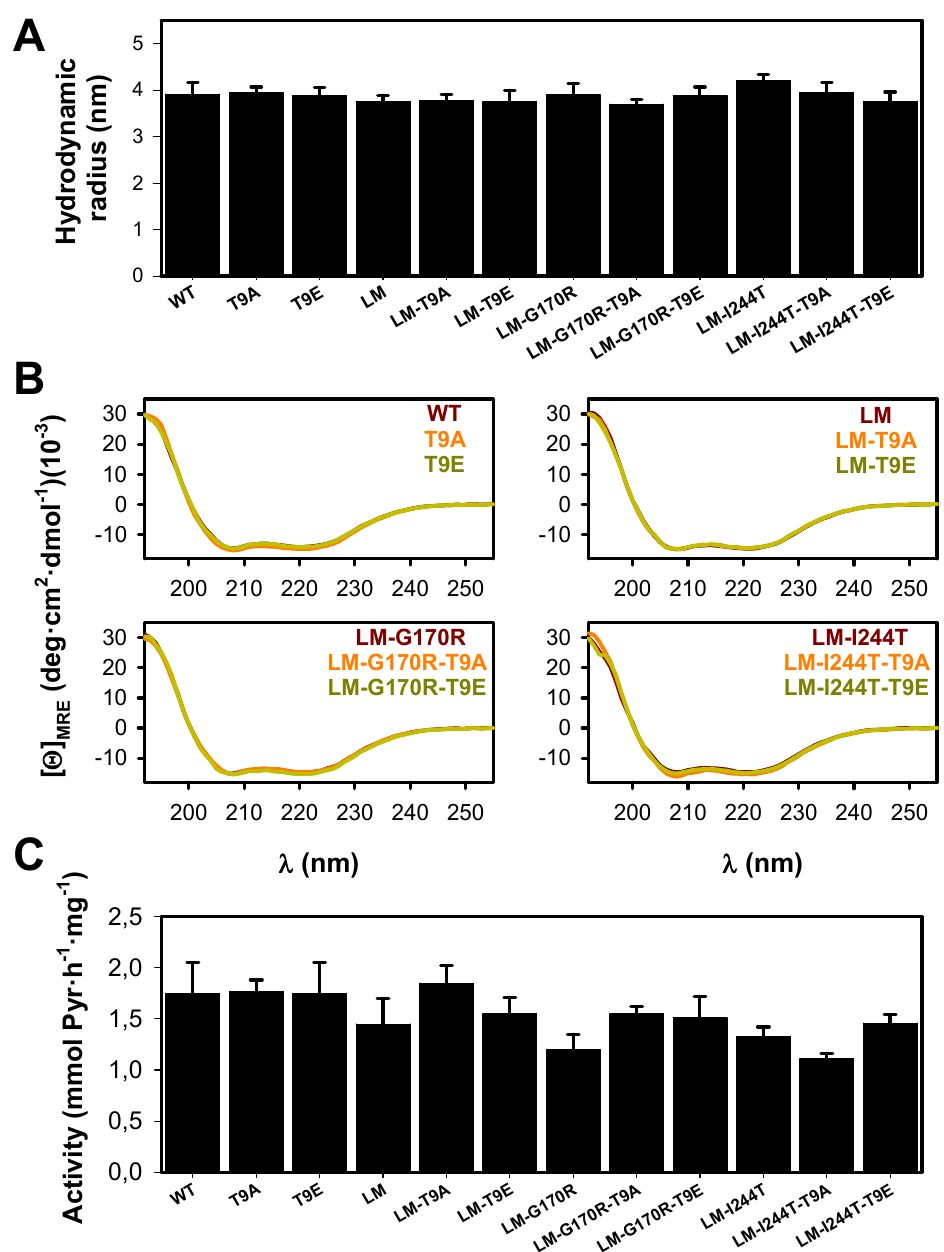
Figure 5. Conformation and activity of AGT variants (WT, LM, LM-G170R and LM-I244T) in the absence or presence of the T9A or T9E mutations. ( A ) Hydrodynamic radii for AGT proteins, as determined by DLS. Data are the mean ± s.d. from three replicates using two different protein preparations. ( B ) Far-UV CD spectra for AGT proteins. Data are the average of two replicas obtained using two different protein preparations. ( C ) Enzyme activity for the overall transamination reaction. Data are the mean ± s.d. from at least five different replicas obtained using two different protein preparations.